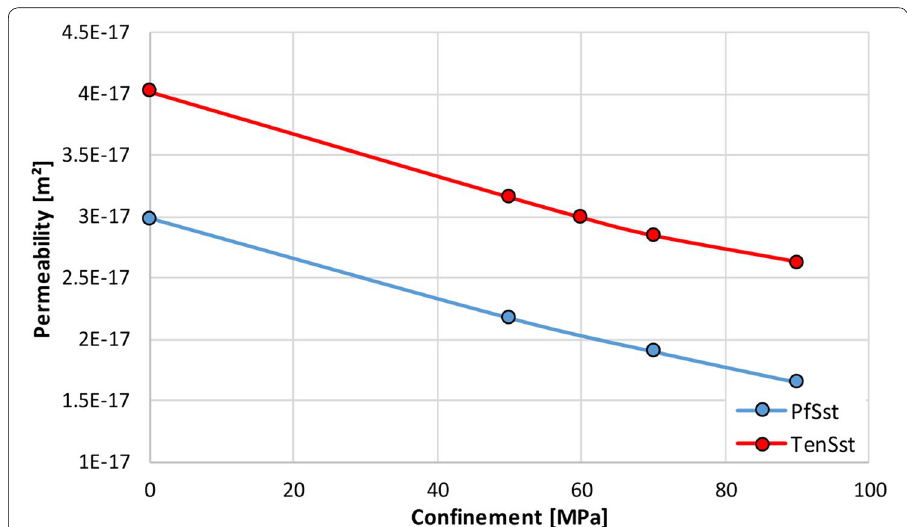
Fig. 9 Permeability changes due to hydrostatic loading calculated from porosity changes for PfSst and